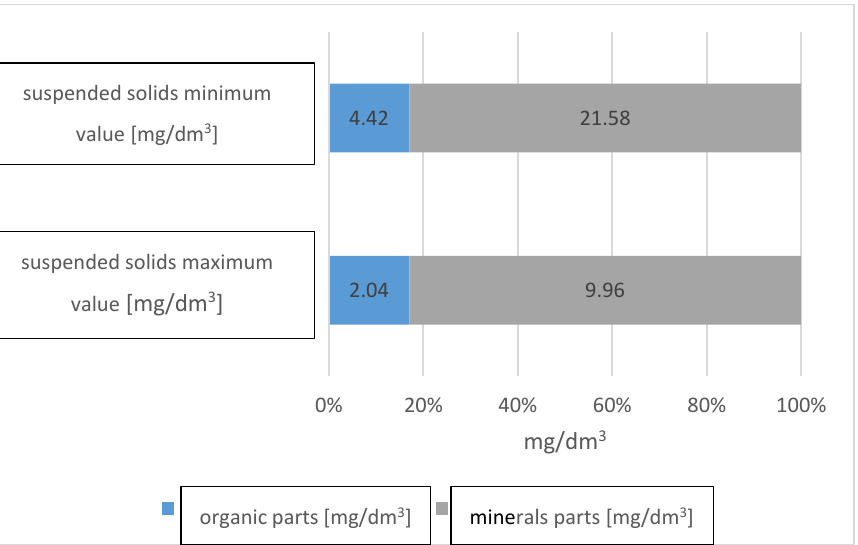
Figure 2. Maximum and minimum amounts of collected suspended solids, divided into organic and mineral components.